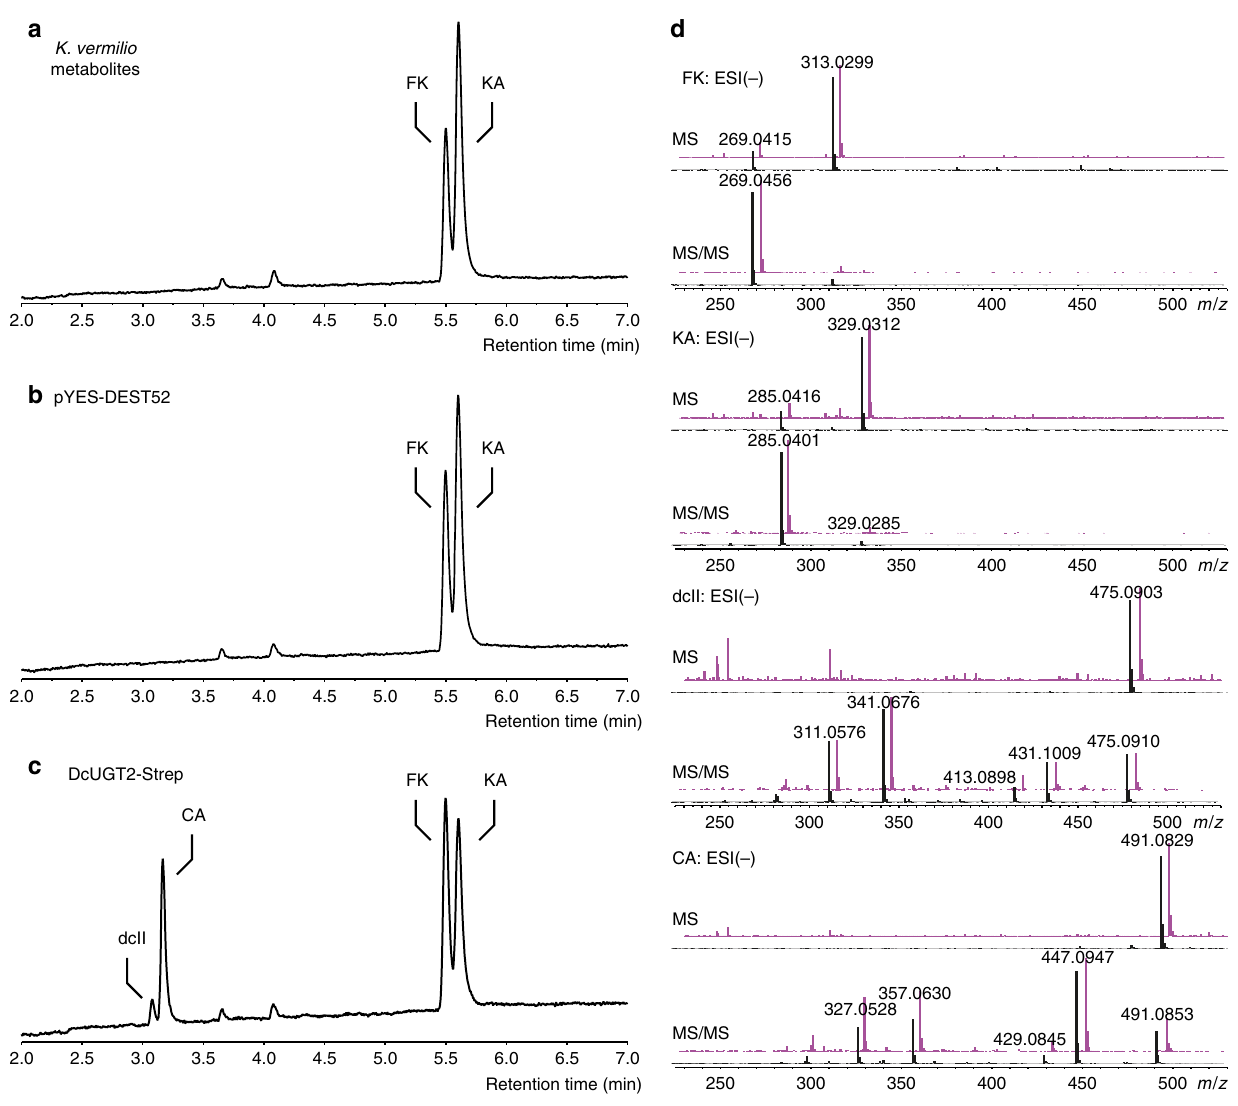
Fig. 5 DcUGT2 catalyzes CA and dcII formation in vitro. Yeast microsomes containing ( b ) pYES-DEST52 vector or ( c ) DcUGT2-Strep were incubated with UDP-glucose and a Kermes vermilio metabolite fraction, containing fl avokermesic acid (FK) and kermesic acid (KA) (shown in a ). Assay products were analyzed by HPLC-HRMS/MS. Peaks indicated in the MS base peak chromatograms ( a – c ) were identi fi ed by comparing retention times and mass fragmentation spectra. Mass spectra of FK, KA, dcII, and carminic acid (CA) identi fi ed in assays ( d , shown in purple) stacked with those of